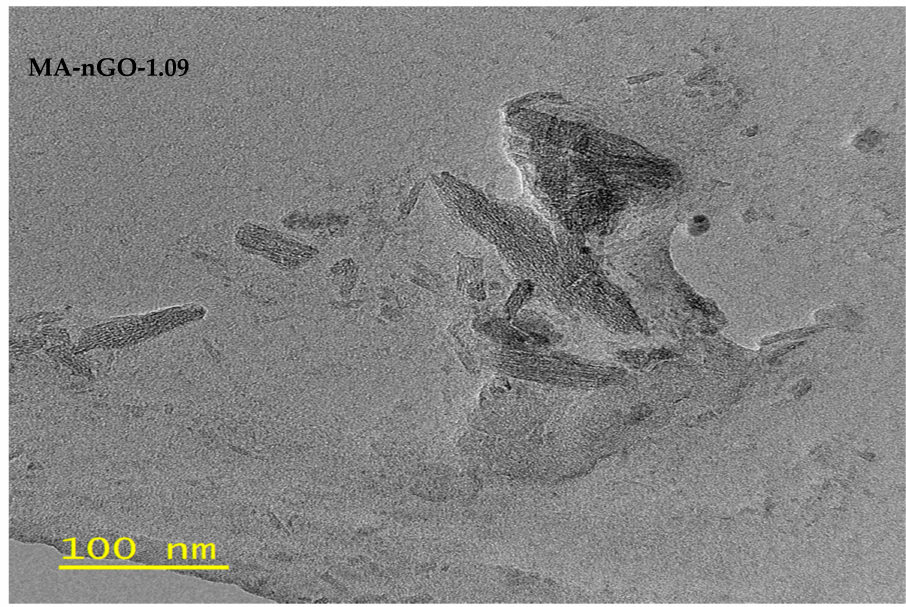
Figure 3. Transmission Electron Microscope (TEM) image of MA-nGO-1.09.